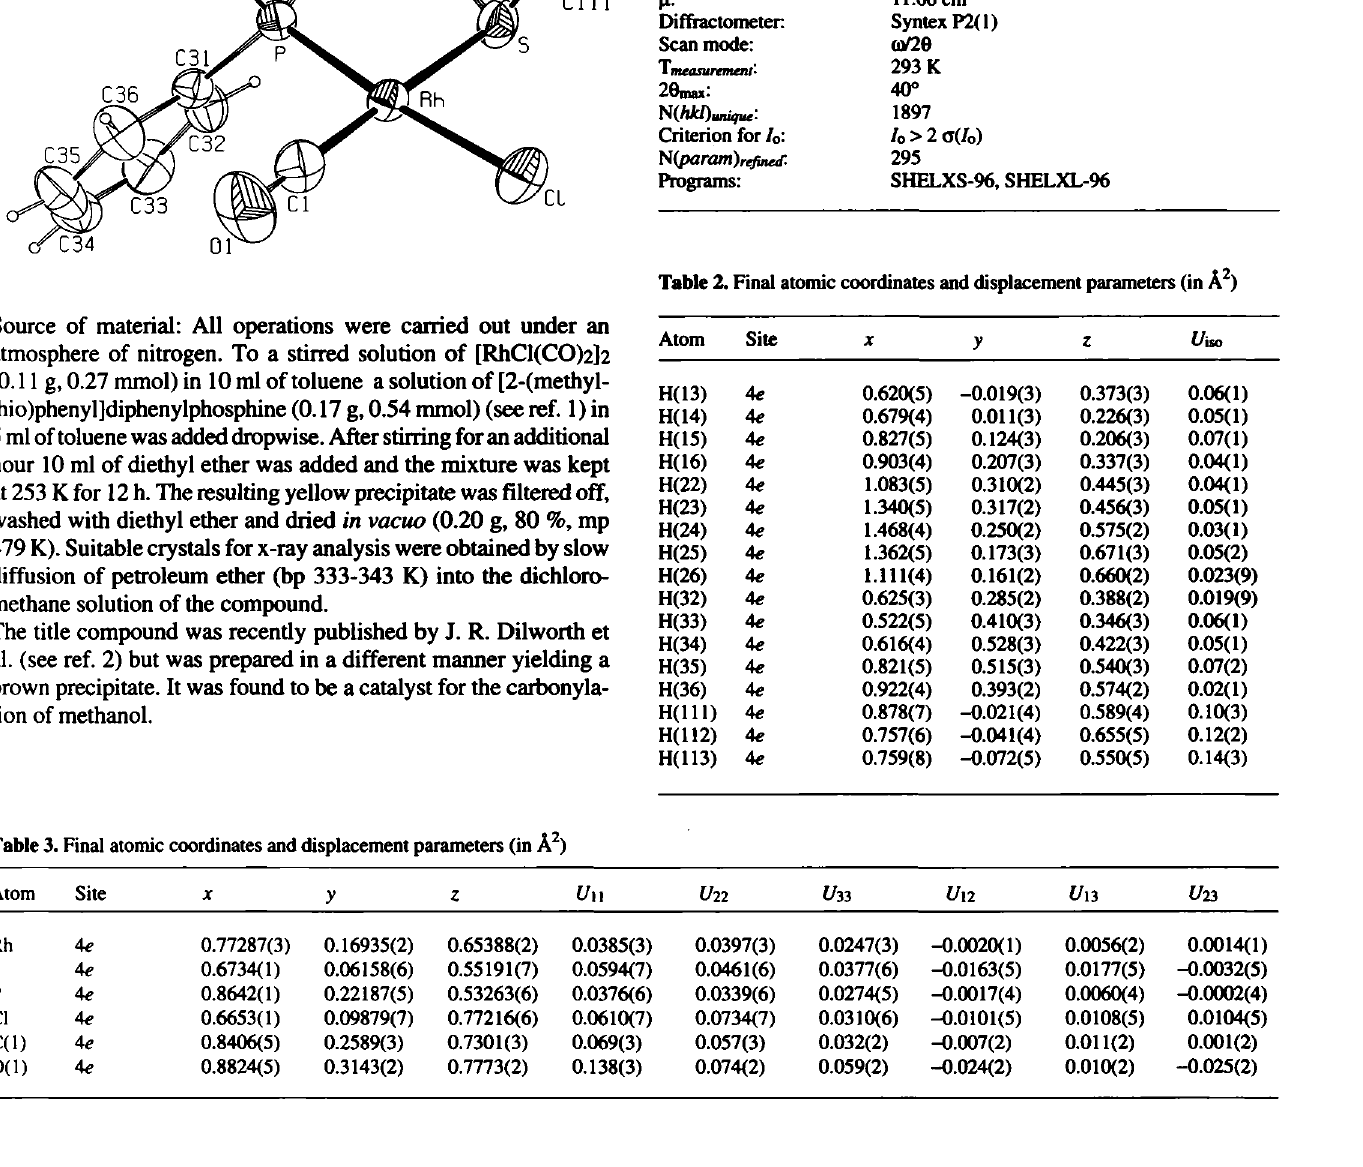
Table 1. Parameters used for the X-ray data collection Crystal: